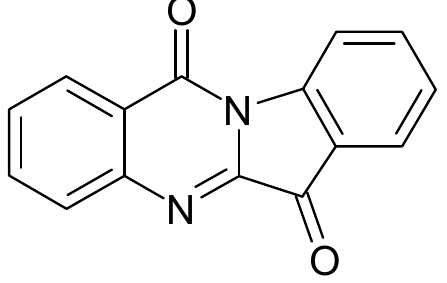
Figure 4. Chemical structure of the alkaloid tryptanthrin.